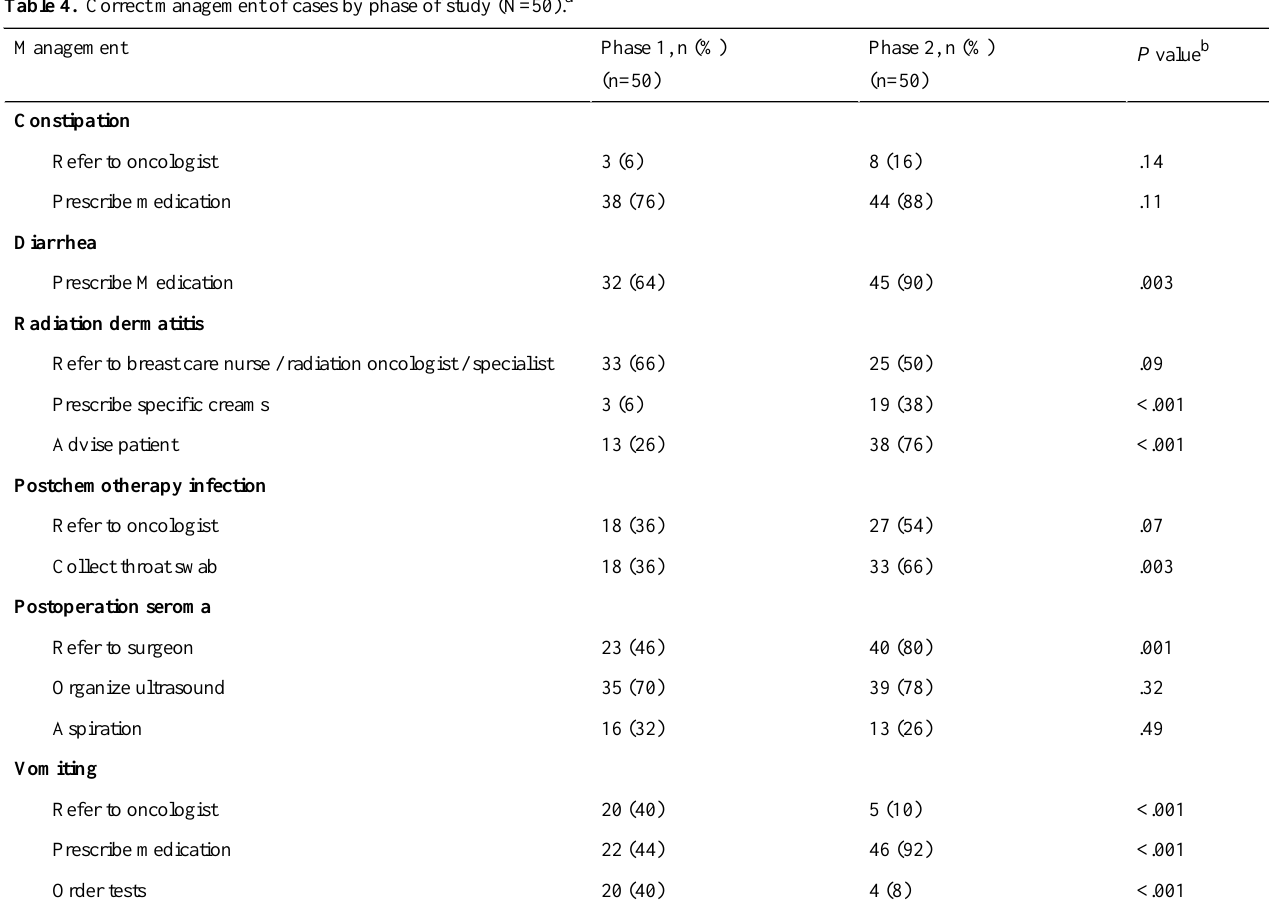
Table 4. Correct management of cases by phase of study (N=50).